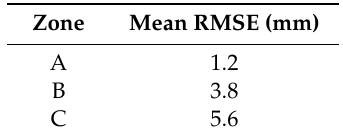
Table 1. Mean RMSEs of the three